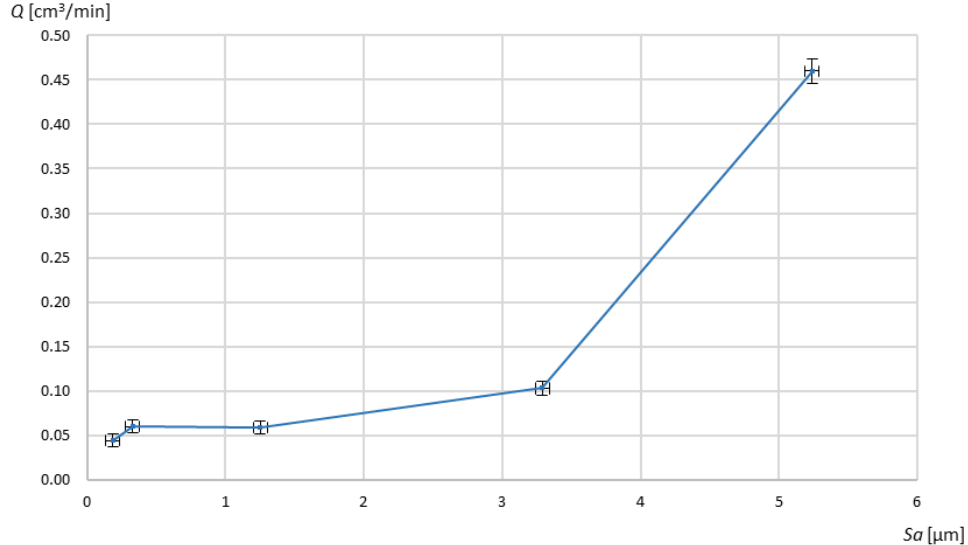
Figure 11. The value of leakage Q as a function of the surface topography parameter Sa for a constant